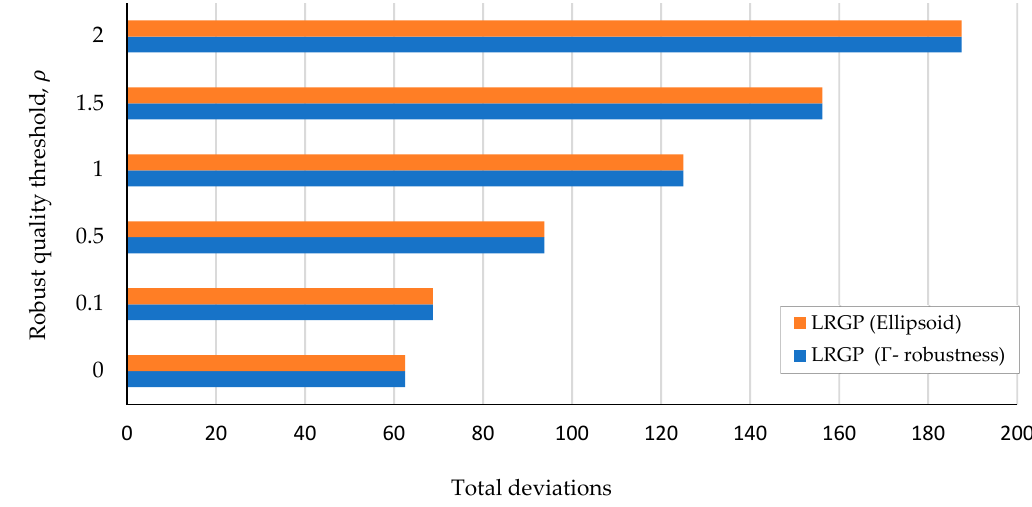
Figure 2. Total goal deviations by LRGP Γ and LRGP e models.